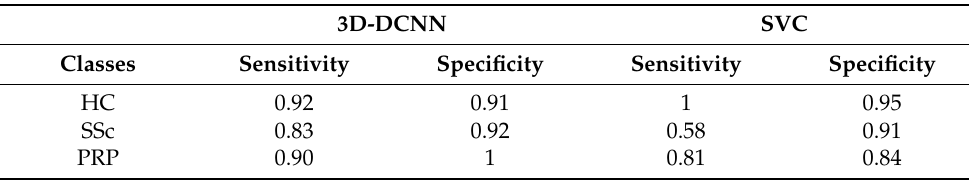
Table 3. Sensitivity and specificity of 3D-DCNN and SVC models on HC, SSc, and PRP participants’ classification.